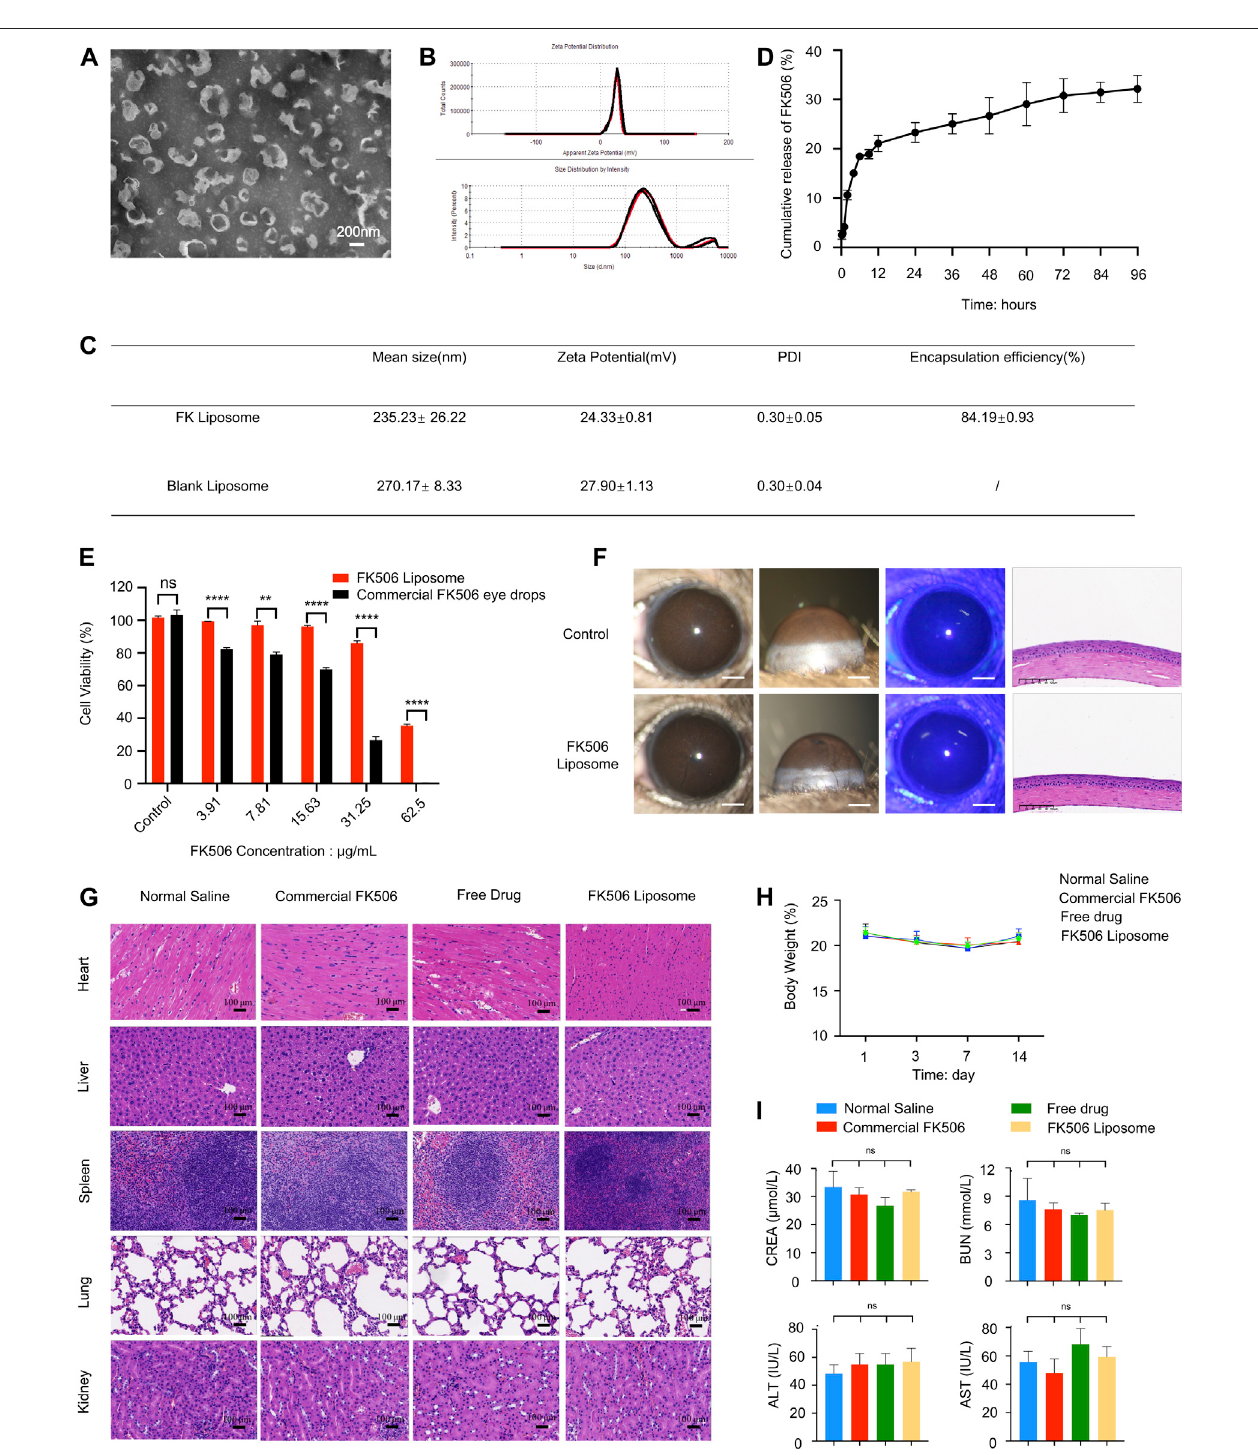
FIGURE 1 | Characterization and biocompatibility evaluation of FK506 liposomes. (A) TEM image of FK506 liposomes. Scale bar: 200 nm. (B) Zeta potential and size distribution of liposomes revealed by dynamic light scattering. (C) Characterization of FK506 liposomes and blank liposomes. (D) In vitro release pro fi le of FK506 liposomes ( n (cid:2) 4). (E) CCK-8 assay of the HCECs exposed to free-drug or FK506 liposomes ( n (cid:2) 3). (F) In vivo biocompatibility evaluation of FK506 liposomes. The corneas were examined with a slit lamp microscope (scale bar: 1 mm), corneal fl uorescein staining (scale bar: 1 mm), and H&E staining (scale bar: 100 μ m) after 14 days of treatment with NS or FK506 liposomes (0.2 mg/ml). (G) Topical application of FK506 liposomes neither in fl uenced the function of the main organs in vivo (scale bar: 100 μ m) nor changed the (H) body weight of the mice in the four groups during the 14-days treatment period. (I) Toxicity studies of liver function (ALT, AST)